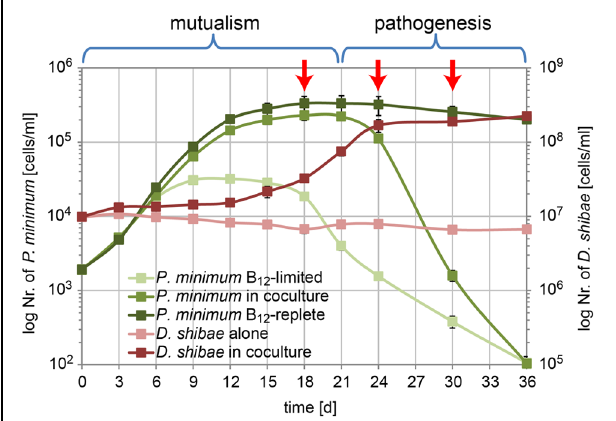
FIGURE 1 | Growth of P. minimum and D. shibae in co-culture. In the mutualistic phase (day 0–day 21) both organisms profit from the co-cultivation in a medium where the dinoflagellate and the bacterium are not able to grow in single culture due to lack of vitamin B 12 and organic carbon, respectively. In the pathogenic phase (day 21–day 36) the algae are killed by the bacteria, which continue to grow. Red arrows indicate the sampling time points for transcriptome analysis (modified from Wang et al.,